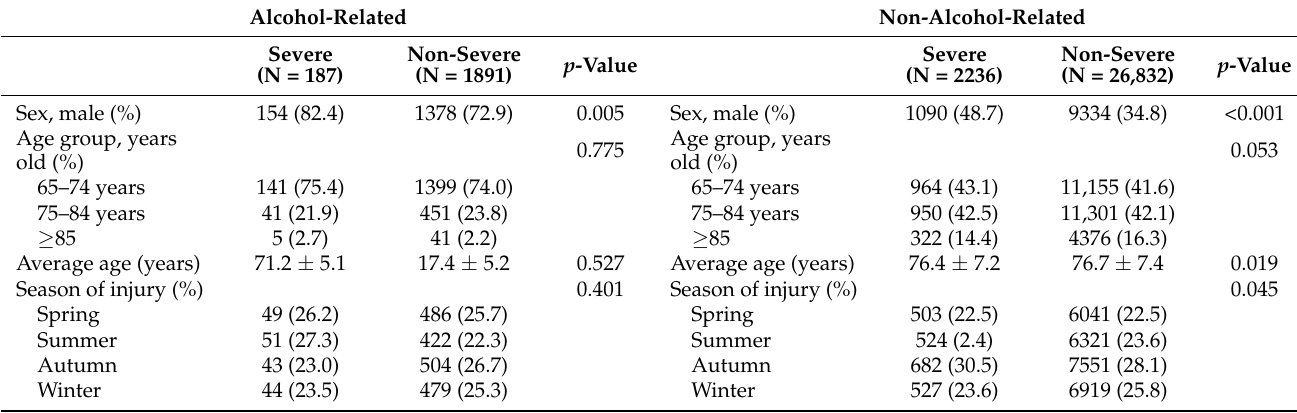
Table 3. General characteristics of alcohol- and non-alcohol-related ground-fall injuries in the elderly according to severity of